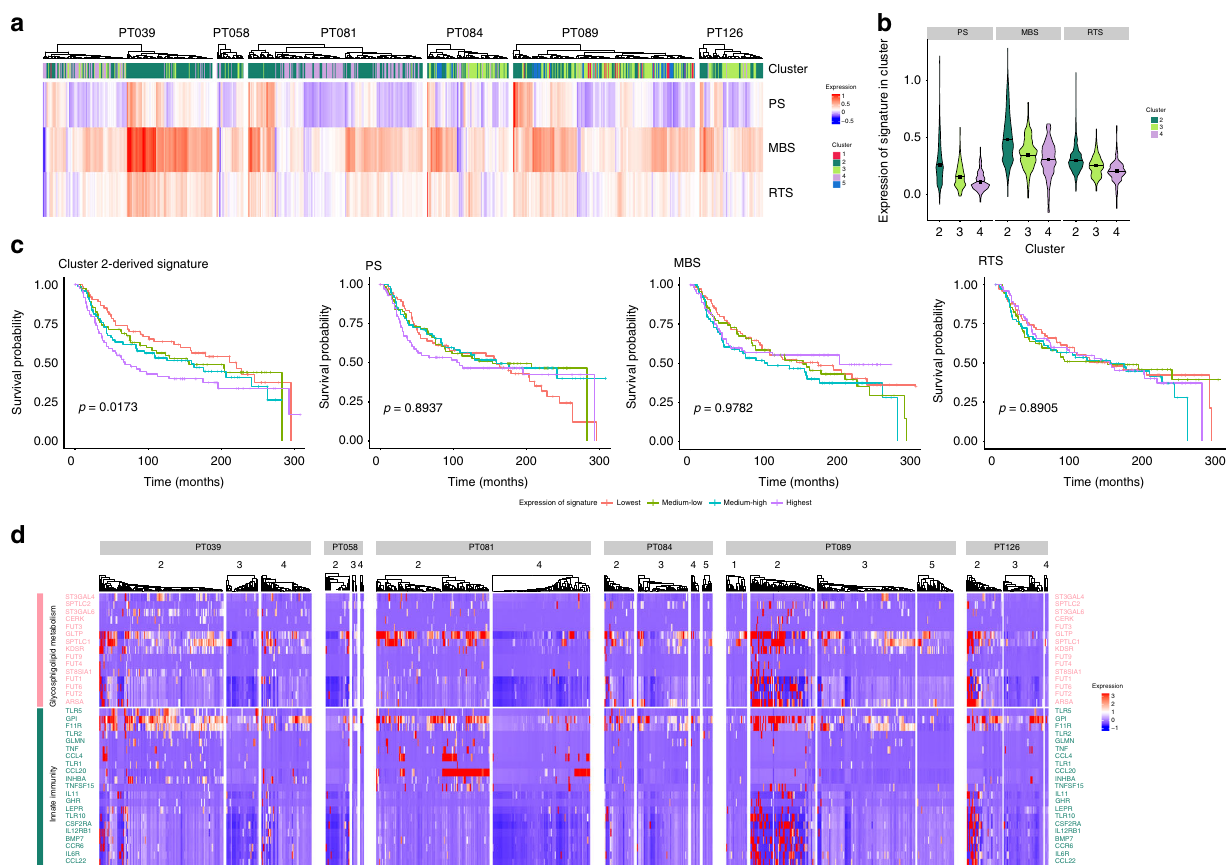
Fig. 4 A cluster 2 subpopulation signature predicts poor patient outcomes and re fl ects glycosphingolipid and innate immunity pathways. a Heatmap depicting the cluster assigned to each cell (top) and the corresponding expression of three signatures related to aggressive disease behavior: 70-gene prognostic signature (PS), 49-gene metastatic burden signature (MBS), and 354-gene residual tumor signature (RTS) (rows). b Violin plots representing the distribution of expression among cells within the indicated clusters of the three signatures related to aggressive disease behavior. Black squares represent average expression of each signature among the cells of the corresponding cluster. c Kaplan – Meier survival curves for TNBC patients in the METABRIC cohort by expression quartiles of the cluster 2-derived gene signature (left). Higher expression of the signature is signi fi cantly associated with worse patient outcome (log-rank test, p = 0.0173). The other three signatures related to aggressive disease behavior are not predictive of survival (right). Separation on quartiles is for visualization purposes. d Heatmap demonstrating expression of genes in the glycosphingolipid metabolism and innate immunity pathways in the epithelial clusters (indicated at top) across all patients. Cluster 2 is signi fi cantly enriched for expression of genes in